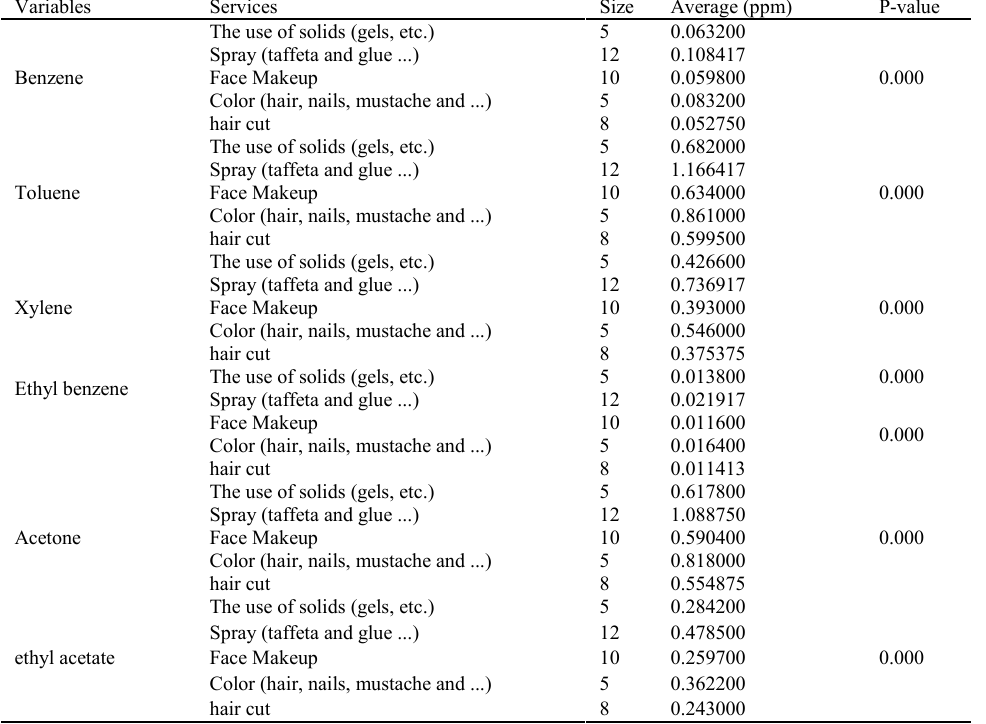
Table 6. Impact of the type of service provided during measurement on the volatile organic compound